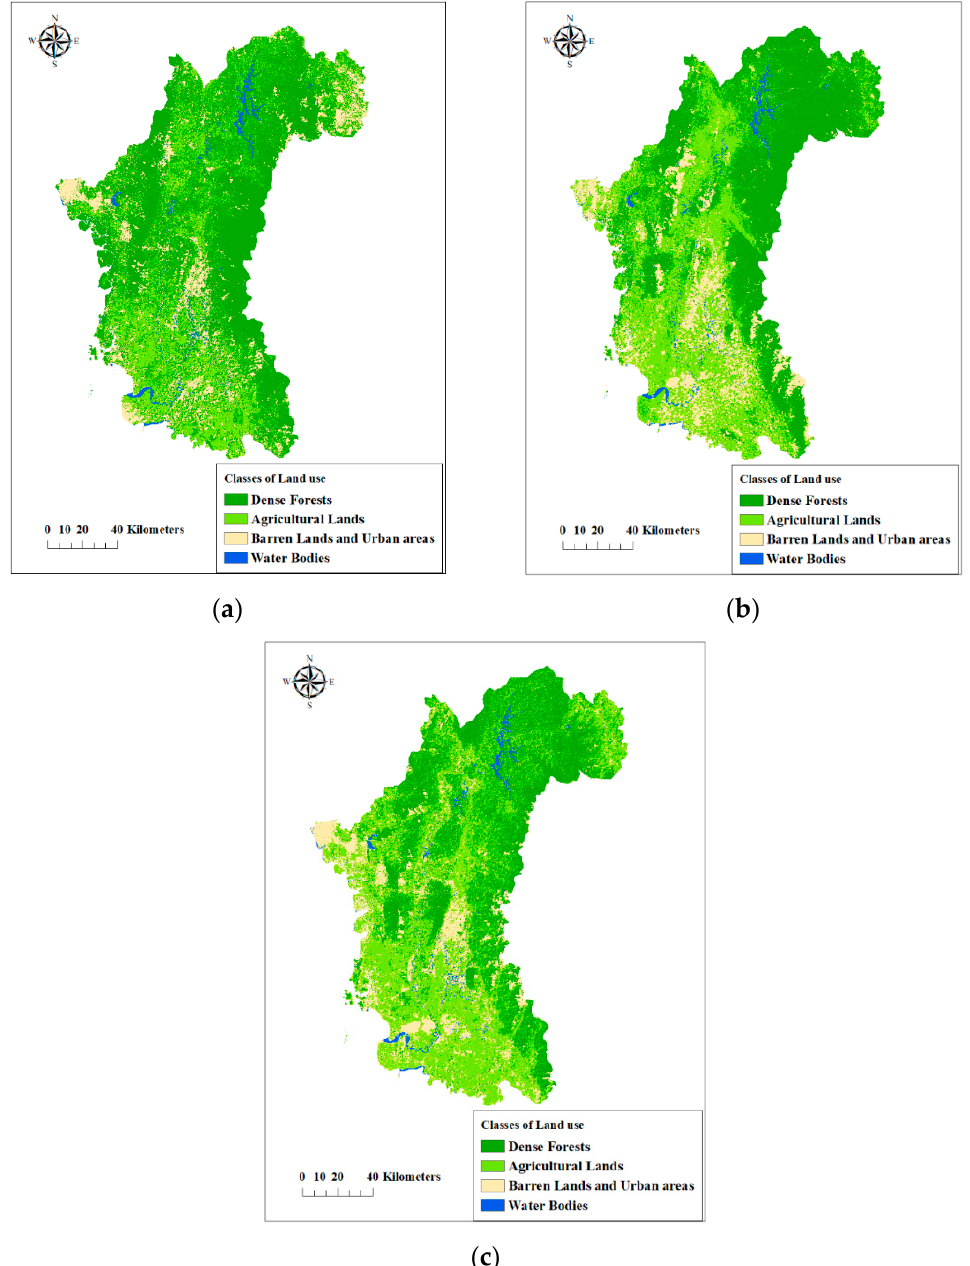
Figure 6. Land use and land cover classifications of Perak River basin for: ( a ) year 2000; ( b ) year 2010; and ( c ) year 2020.